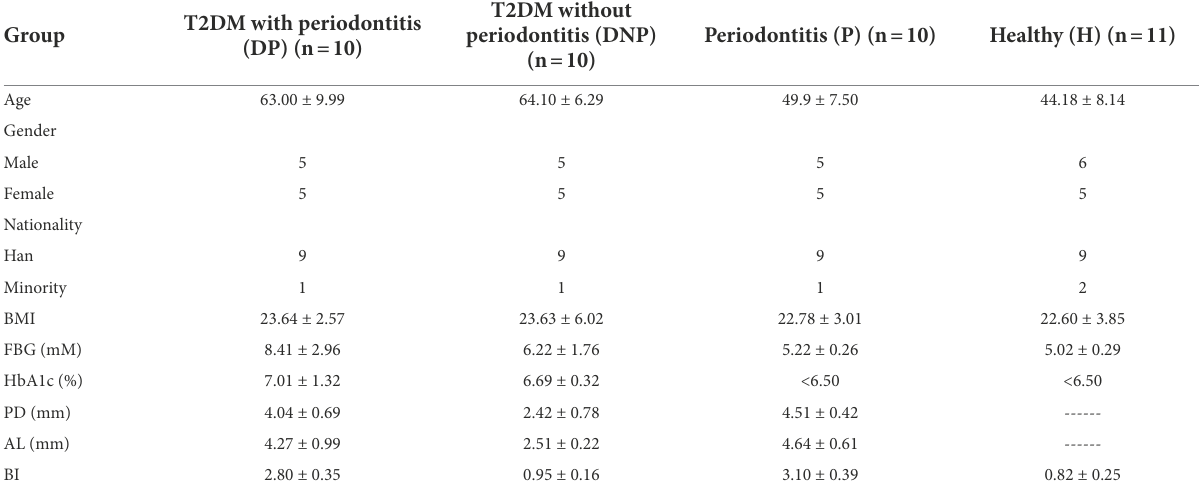
TABLE 1 Demographic and clinical characteristics of